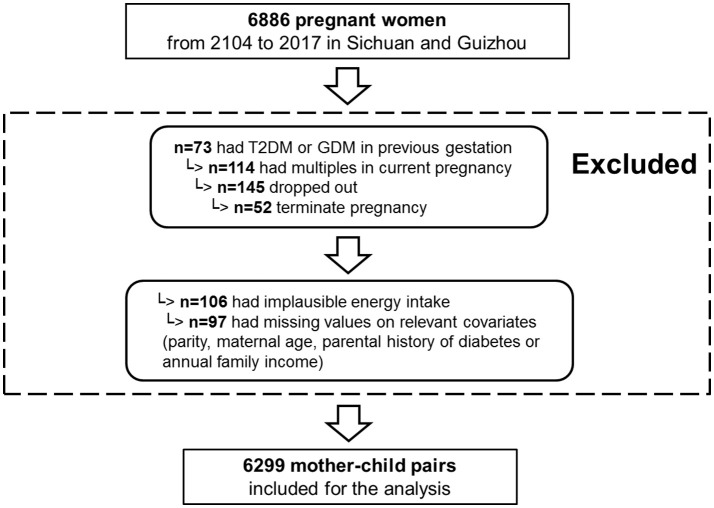
Flowchart for the study sample.